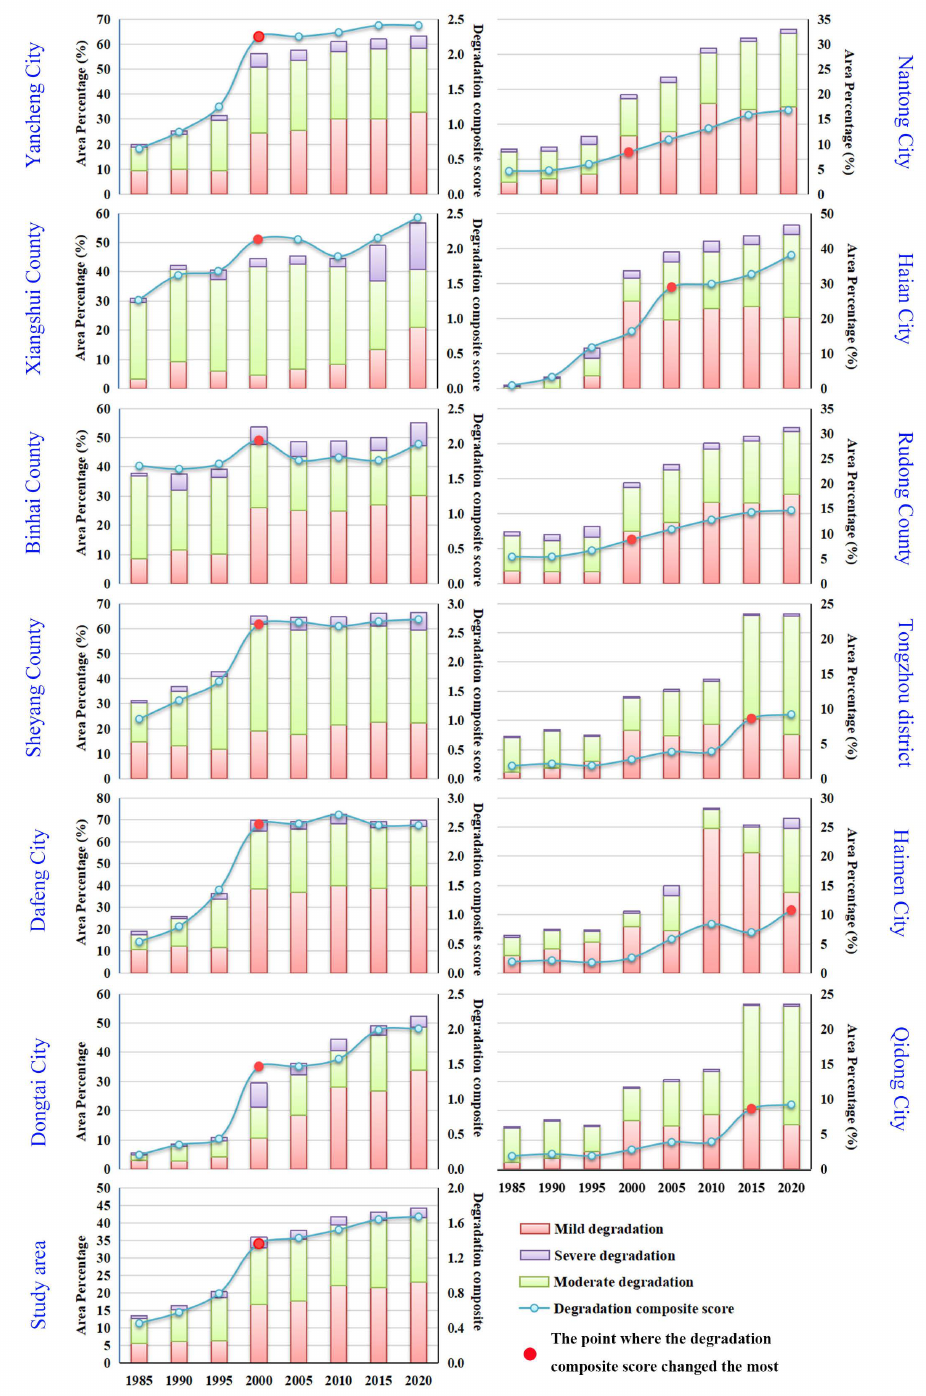
Figure 7. Changes in the overall degradation score and areal proportion of each degradation class of coastal